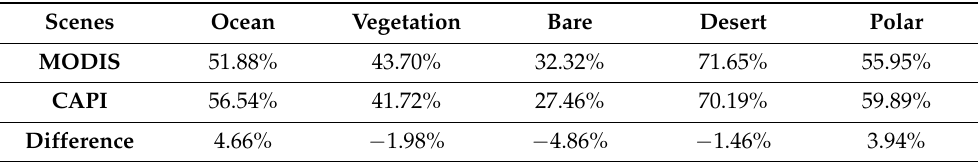
Table 5. The cloud cover identified from MODIS and CAPI images.